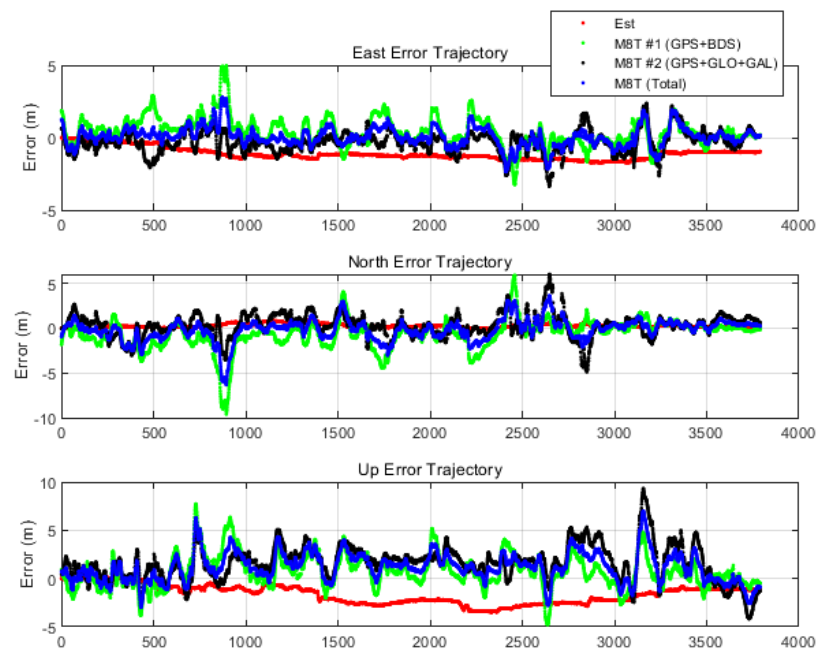
Figure 16. Time history of ENU errors with filtered solutions (1 h).